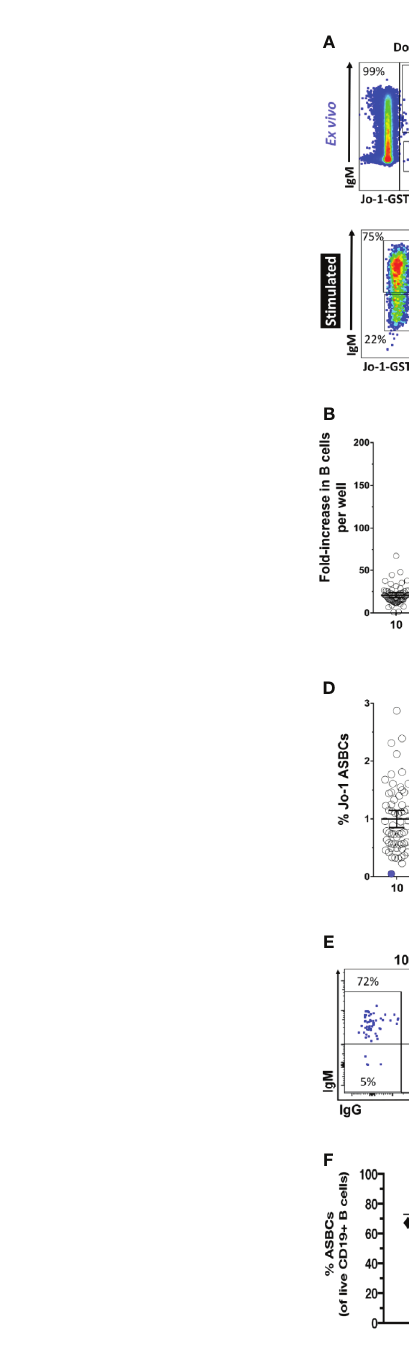
FIGURE 6 | Autoreactive Jo-1-binding ASBCs expand in response to in vitro stimulation. PBMCs were isolated from n = 4 Jo-1 anti-histidyl tRNA synthetase syndrome patients, and (A) representative plots show fl ow cytometry identi fi cation of total B cells as well as Jo-1-binding ASBCs ex vivo and following stimulation in vitro for 1 wk as in Methods (gated on CD19 + live singlet lymphocytes). 3.3x10 4 PBMCs were stimulated per well in 96 well plates as in Methods. An average input total B cell and Jo-1-binding B cell frequency per well was calculated based on ex vivo fl ow phenotyping data. After 1 wk of stimulation, individual wells were harvested and fl ow cytometry was used to determine output total B cell and Jo-1-binding ASBC frequency per well. Output frequency/input frequency was used to calculate estimated fold expansion for (B) total B cells or (C) Jo-1-binding ASBCs in each well. Individual wells are plotted. (D) The frequency of Jo-1-binding ASBCs ex vivo (purple symbol) or following in vitro stimulation (open symbols) is shown for each donor; individual wells are plotted. (E) Representative plots show fl ow cytometry identi fi cation of Jo-1-binding ASBCs by IgM and IgG isotypes (gated on Jo-1-GST + CD19 + live singlet lymphocytes). (F) The isotype frequency of Jo-1- binding ASBCs following in vitro stimulation is shown for each donor; individual donors are